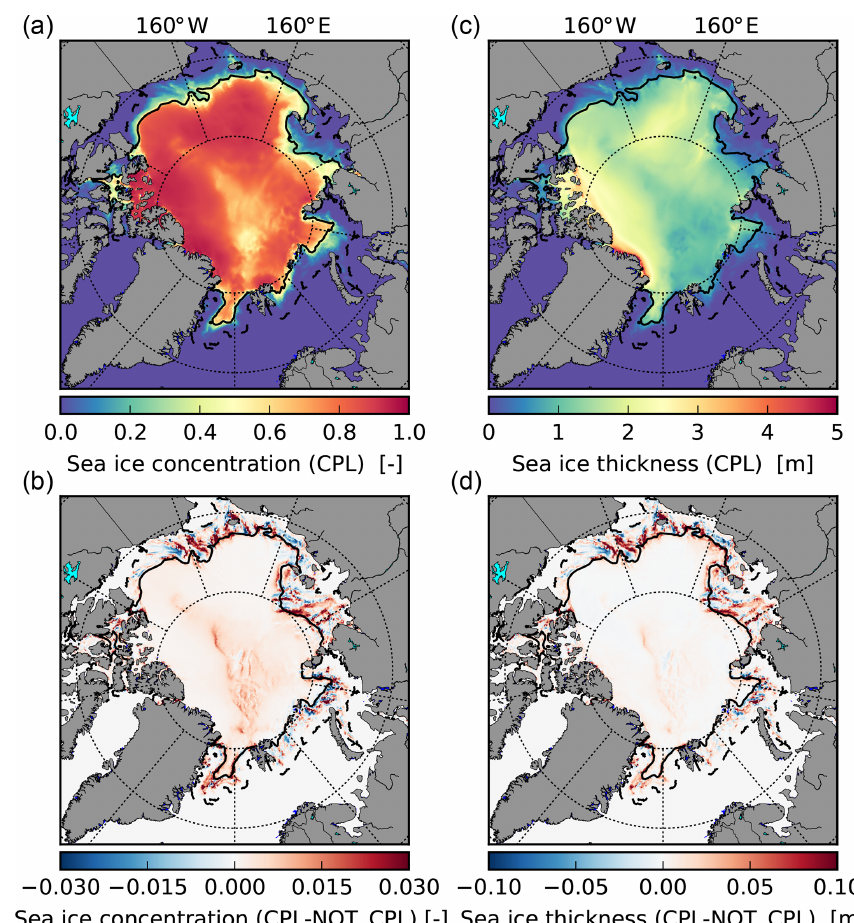
Figure 7. Sea ice concentration and thickness in the CPL simulation (a, c) and the differences with NOT_CPL (b, d) averaged over the period 4 August 2010 to 9 September 2010. The black contours delimit the MIZ in the CPL simulation, defined here as 0 < (cid:104) D max (cid:105) < 700